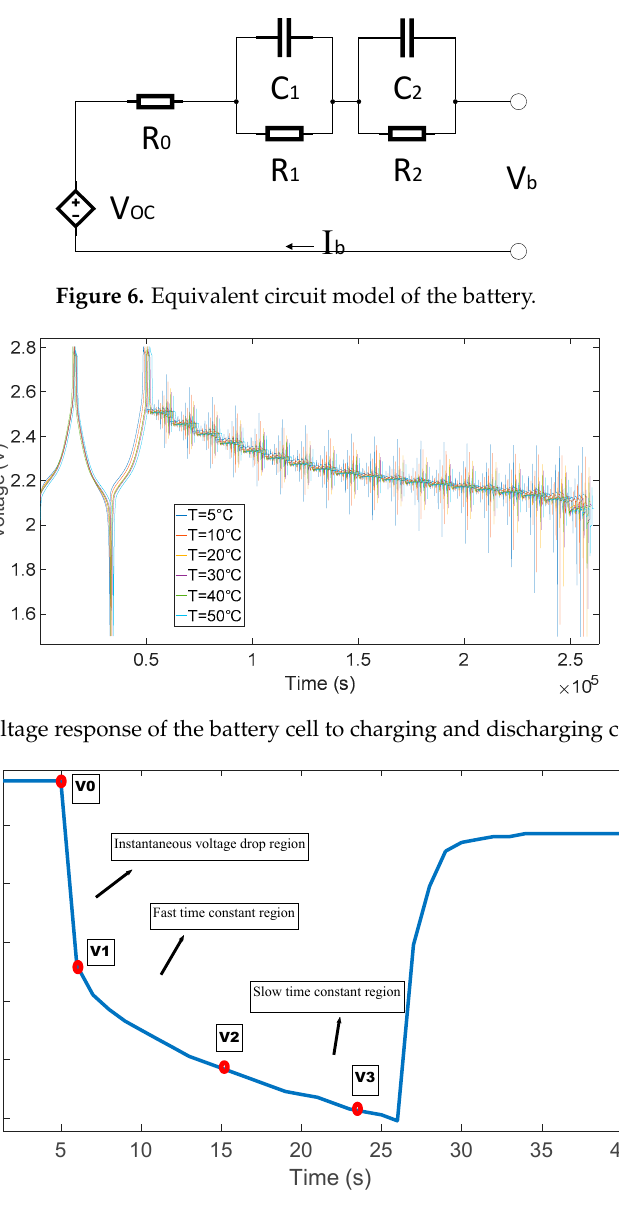
Figure 8. The voltage response of the battery cell for 4 C discharge at 30 °C.